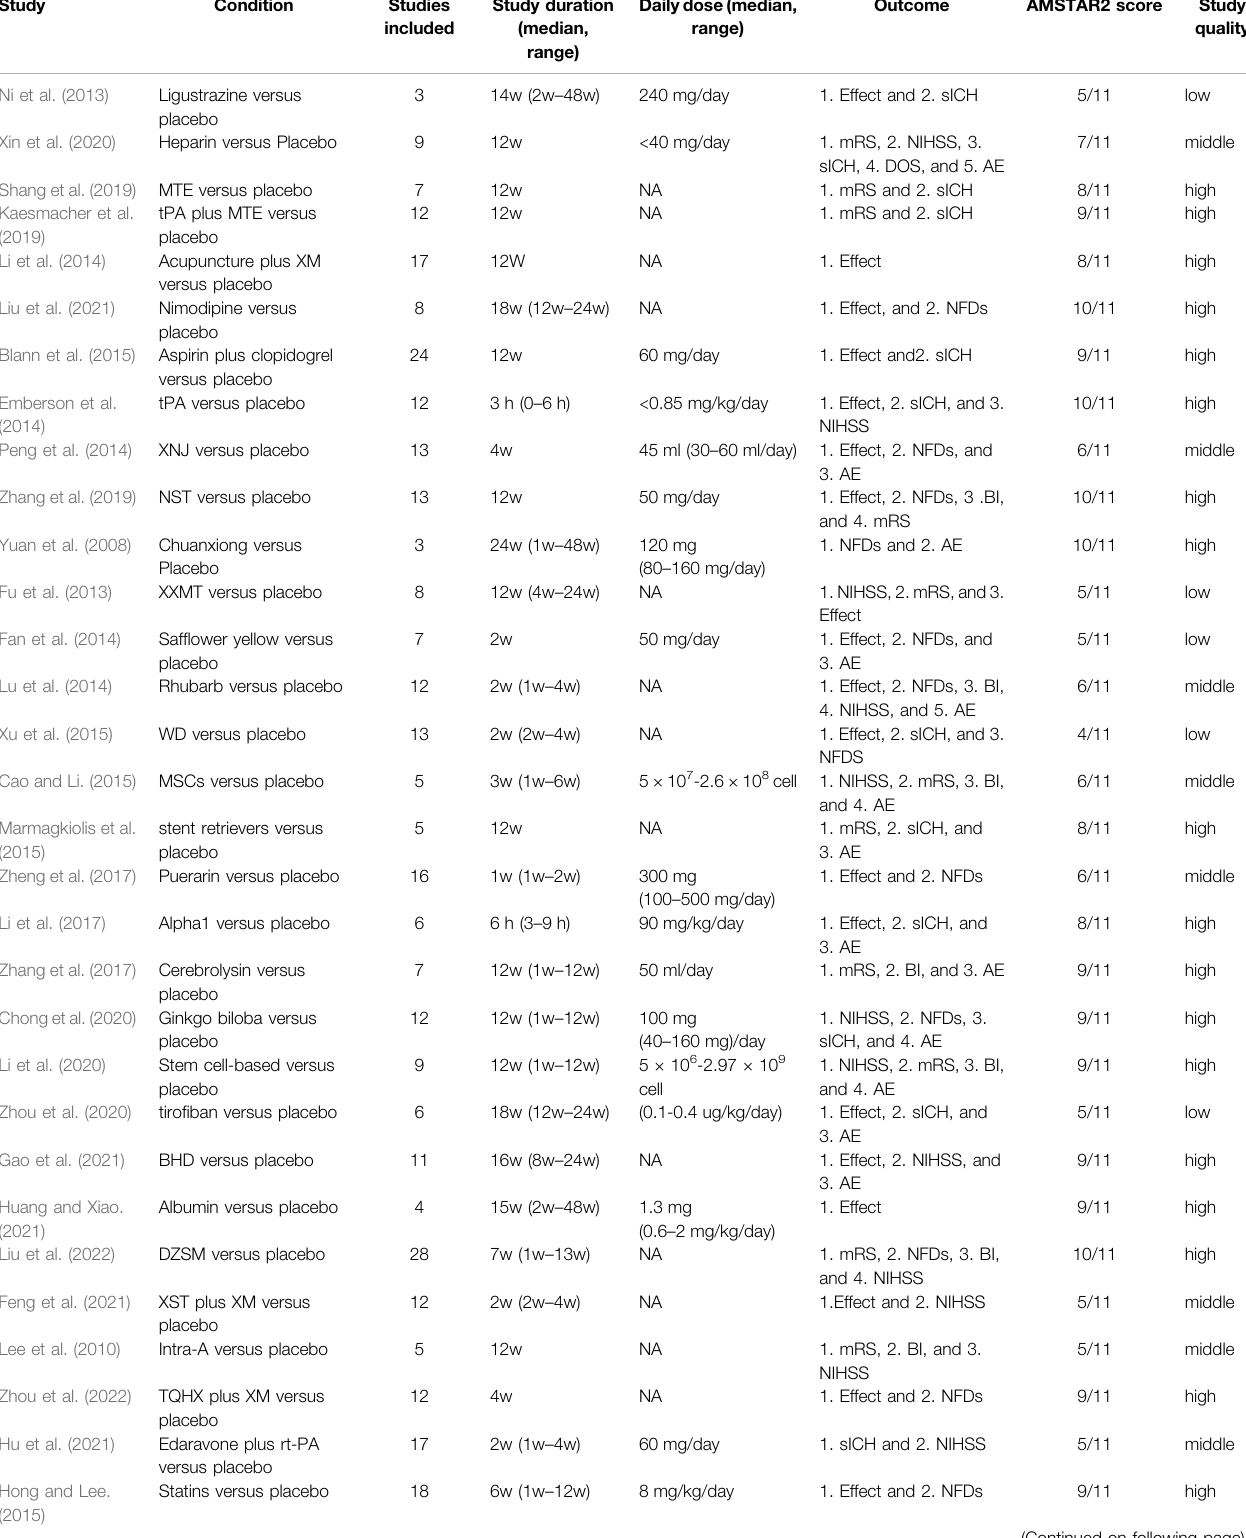
TABLE 1 | Description and AMSTAR2 scores of included